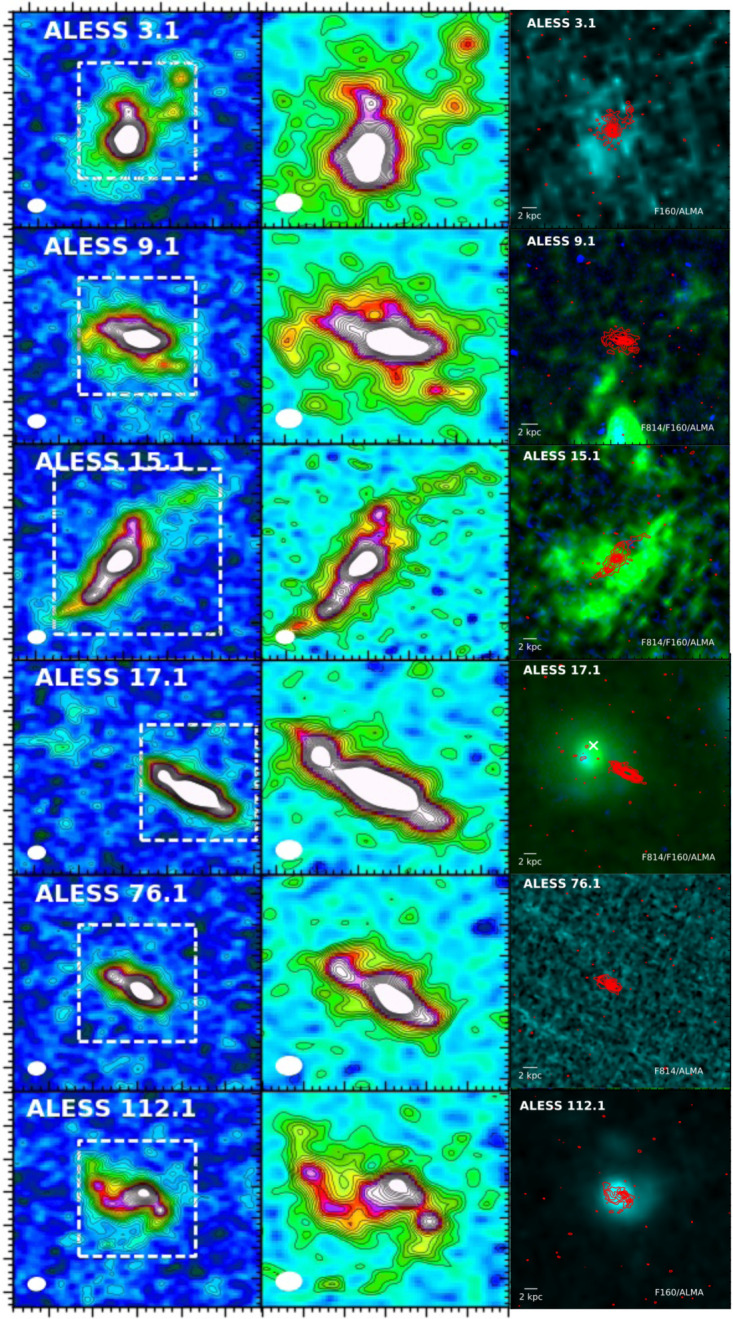
ALMA 870 μm dust continuum in high-redshift SMGs from Hodge et al. [439] shown as 1.3″ × 1.3″ panels with natural weighting (left column); with robust weighting and zoomed-in to the white dashed boxes (middle column); and as red contours on 4″ × 4″ HST false-colour images. The resolution achieved in the middle column corresponds to approximately 500 pc at the redshifts of these sources, allowing a detailed view of these dust-obscured galaxies. The robust dusty substructure observed in these sources with ALMA is uncorrelated with the unobscured stellar populations traced by the HST imaging. Figure adapted from Hodge et al. [439].